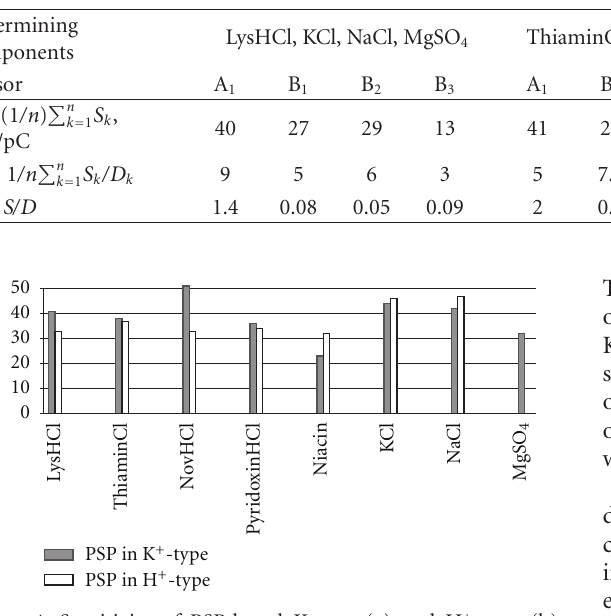
Figure 4: Sensitivity of PSP-based K-type (a) and H + -type (b) PD sensors in test solutions of LysHCl, ThiaminCl, NovHCl, PyridoxinHCl, Niacin, NaCl, KCl, and MgSO 4